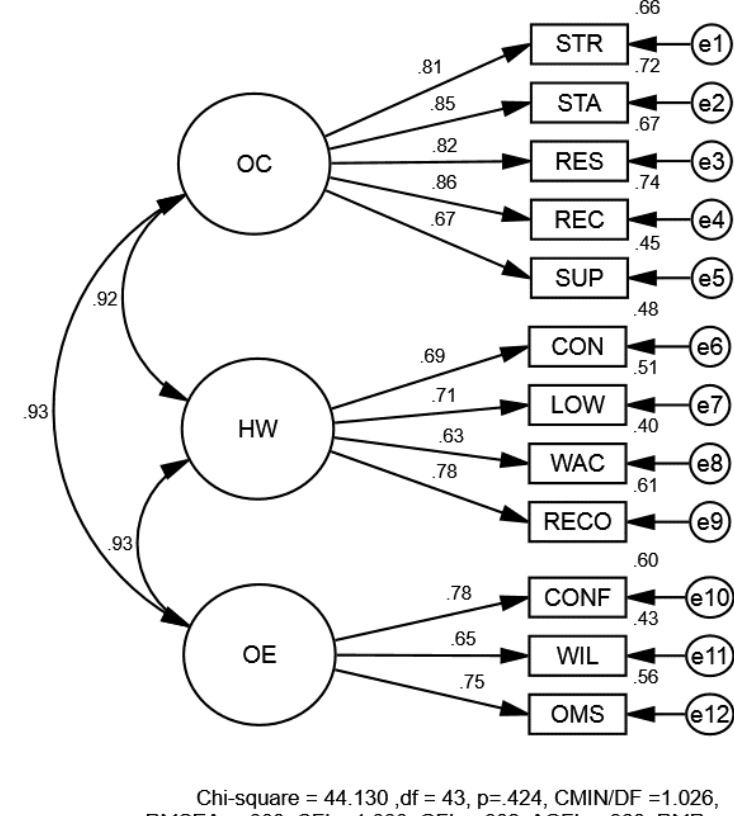
Figure 2. Results of the confirmatory factor analysis to verify the Construct Validity of the latent variables in the model with the statistical